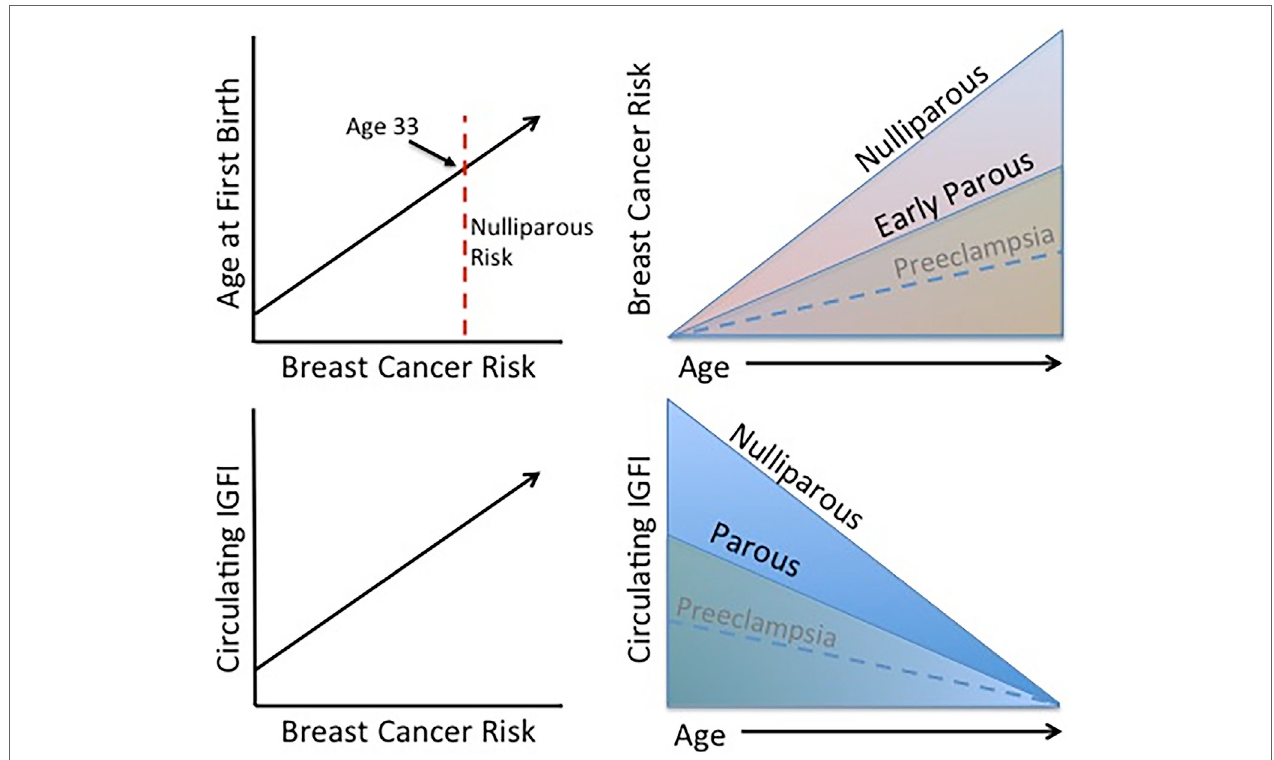
FiGURe 2 | established trends associated with the protective effect of pregnancy . Age at FFTB is positively correlated with breast cancer risk. Women who experience an early parity benefit from a long-term protection against breast cancer compared to nulliparous women. Interestingly, higher levels of circulating IGFI are also positively associated with breast cancer risk and parous women display lower circulating IGFI levels. Although less firmly established, preeclampsia may be associated with a lower breast cancer risk as well as circulating IGFI